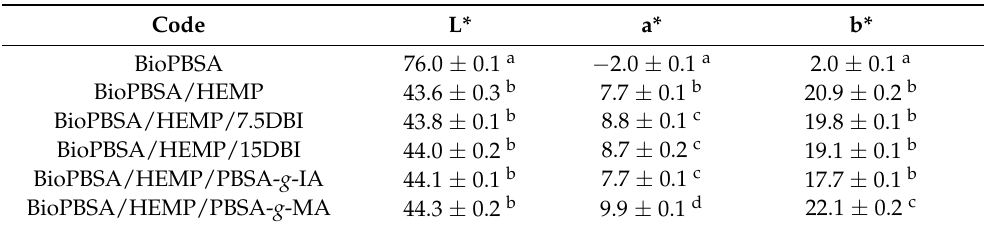
Table 6. CIELab color space measurements in terms of luminance and color coordinates (L*, a*, b*) of BioPBSA/HEMP